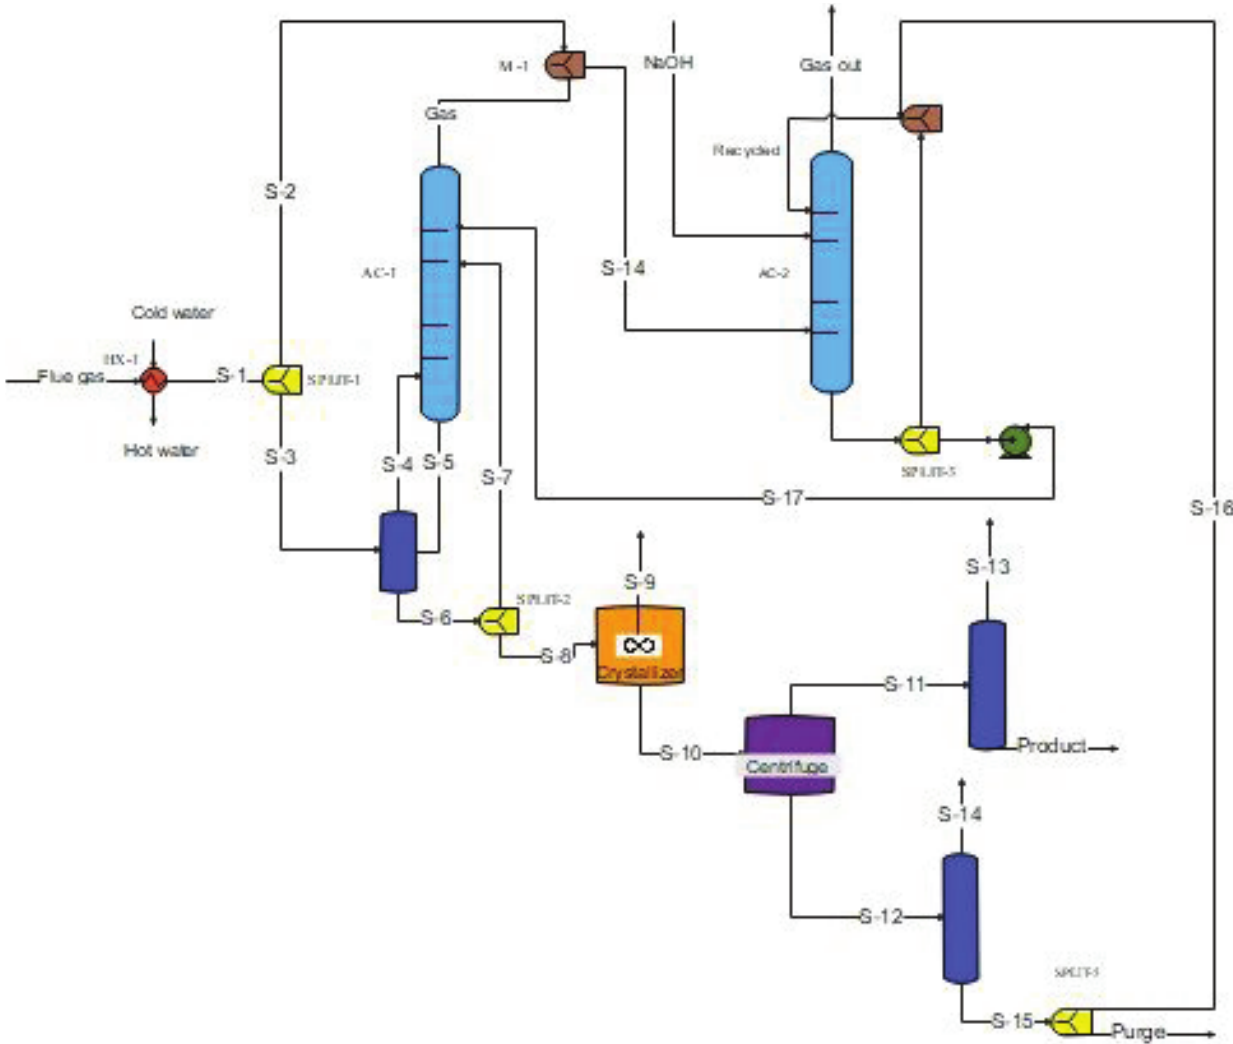
Fig. 5 – Schematic representation of CO